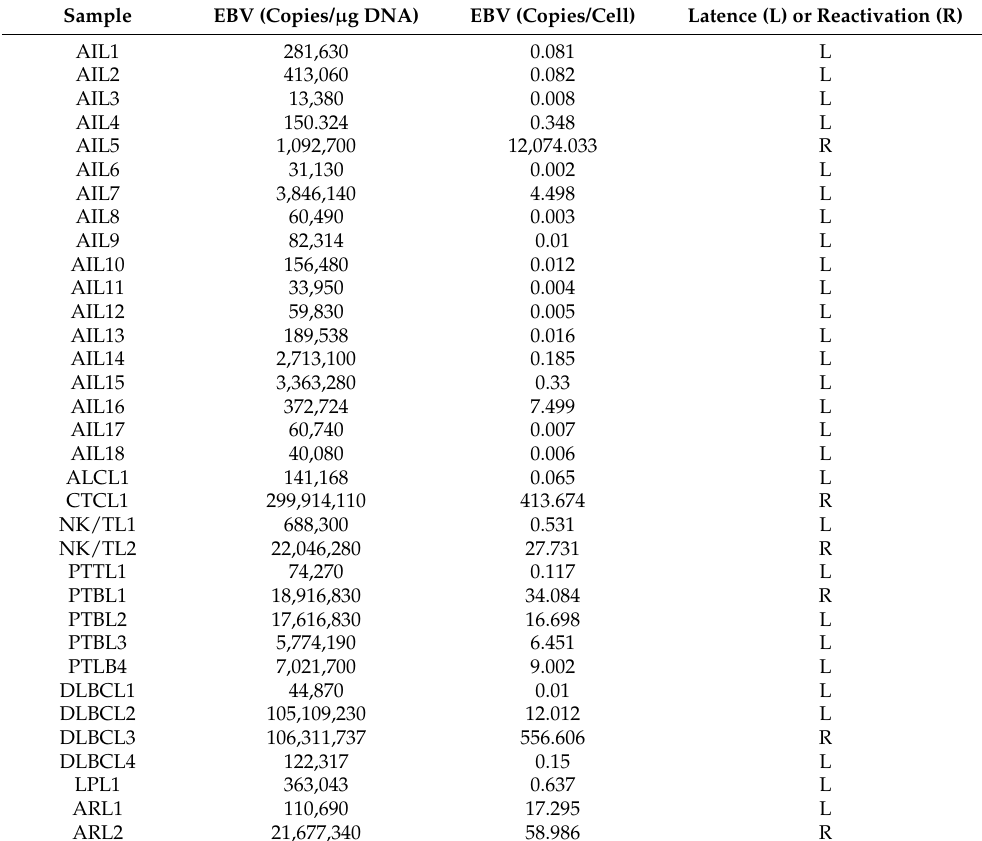
Table 4. Latence/Reactivation State of EBV in Biopsy